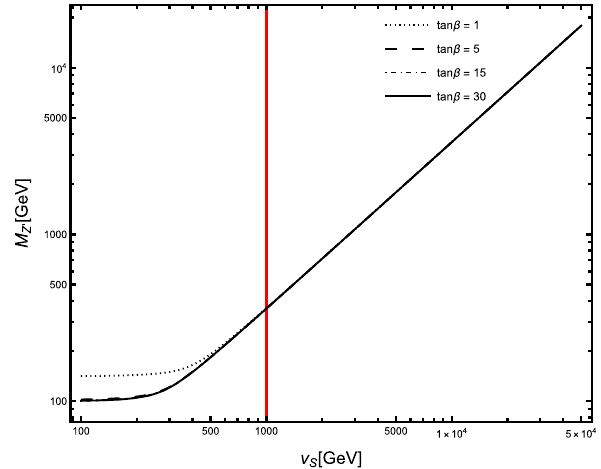
Fig. 1 TeV-range Z (cid:2) mass as a function of v S for different values of tan β and with g Z (cid:2) = g Y . The region at the right of the red vertical line is the one in which the expectation value v S is in the TeV range